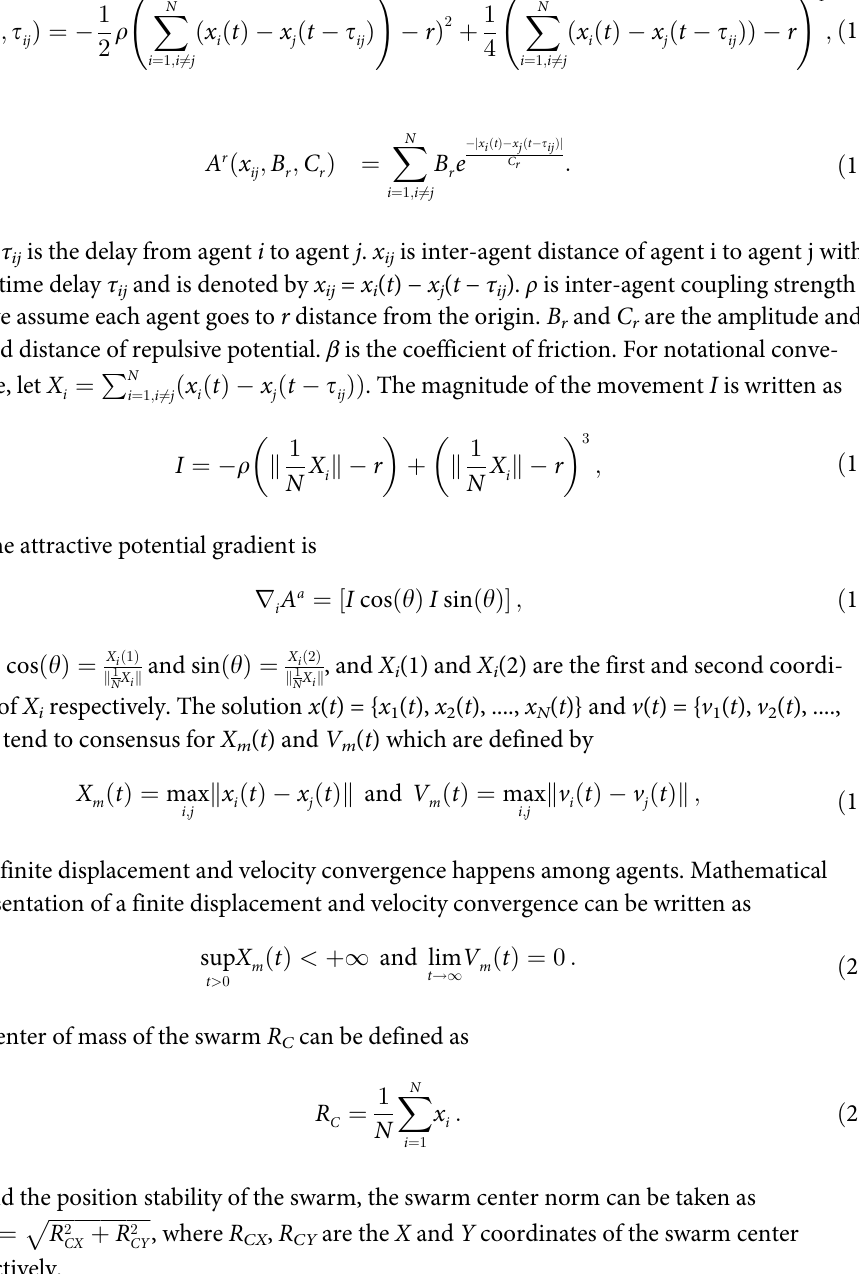
, R are the X and Y coordinates of the swarm CX CY